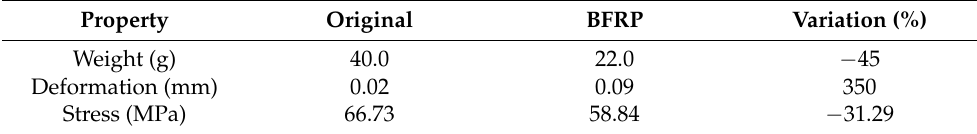
Table 7. Comparison of mechanical